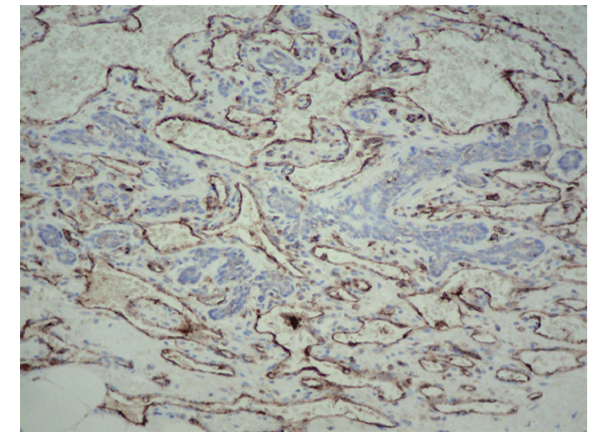
Figure 1: Hematoxylin and eosin stain on an ill-di ff erentiated part of the left breast’s angiosarcoma (200x).